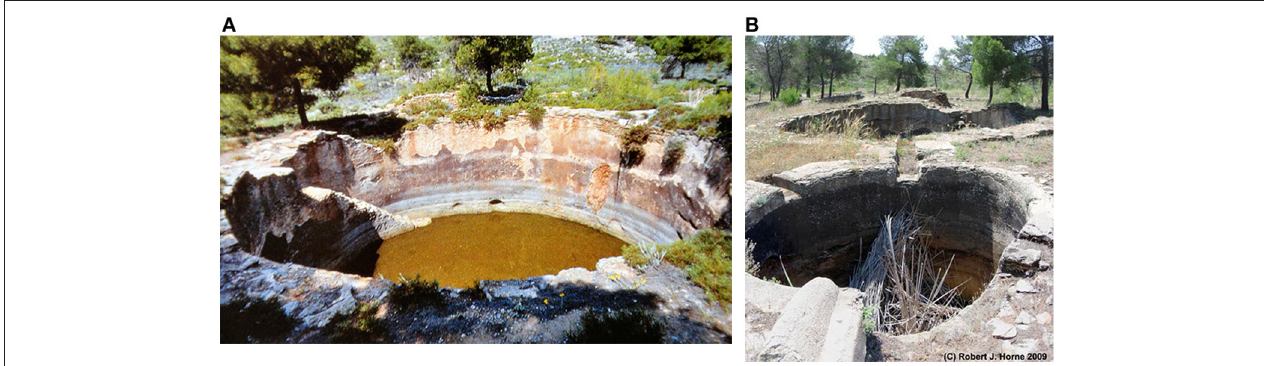
FIGURE 3 | Water cisterns used for water storage and treatment: (A) Cistern for collecting and storing rainwater and (B) a pre-cistern located ahead of the main cistern used to settle out large debris (Tzanakakis et al., 2014).